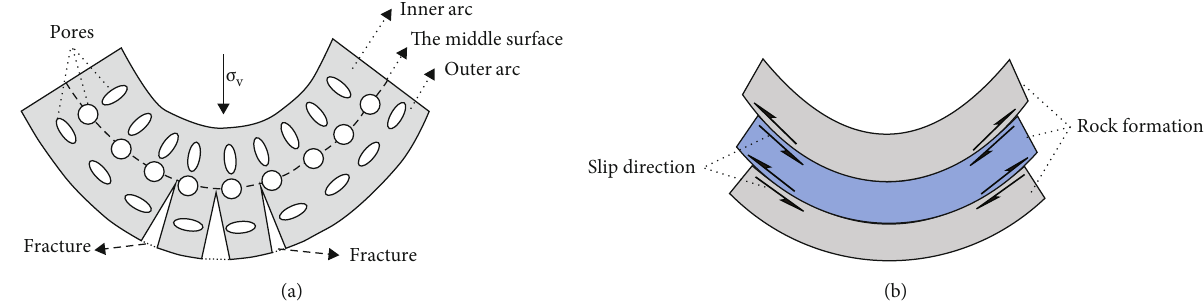
Figure 10: Diagram of the formation process of syncline structure: (a) variation characteristics of a layer of rock when it bends; (b) variation characteristics of multiple layers when they bend.